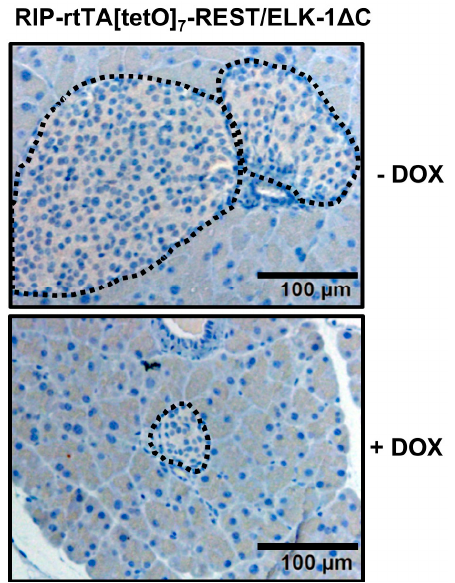
Figure 5. Formation of smaller islets in transgenic mice expressing REST/Elk-1 Δ C in pancreatic β -cells. Sections of pancreata were stained with hematoxylin. Expression of REST/Elk-1 ∆ C was induced by doxycycline (DOX) administered with drinking water. This was reproduced with modifi- cations from [26] with permission from Elsevier.